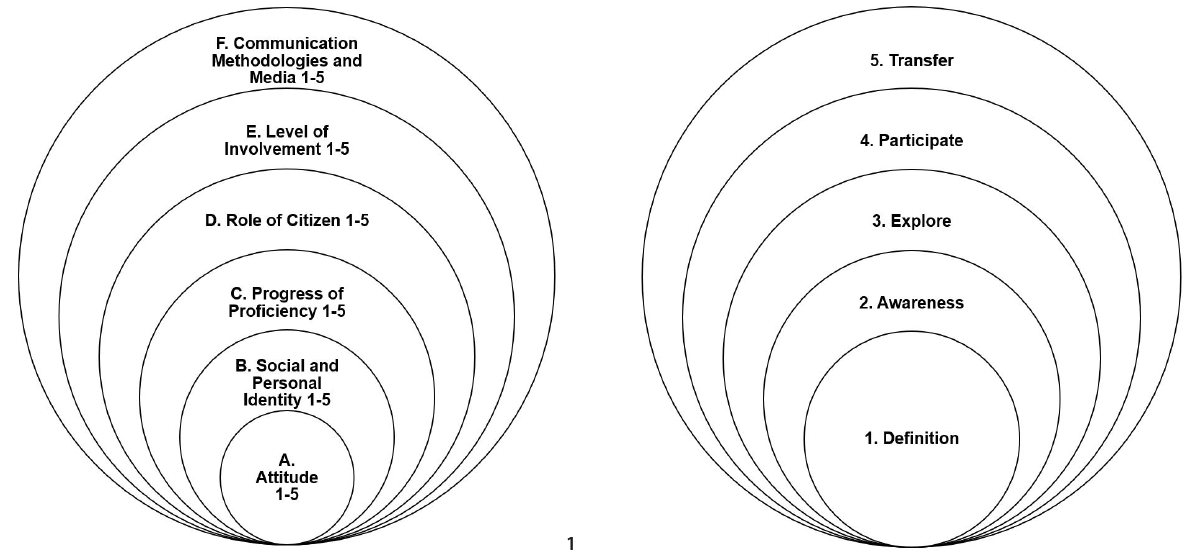
Figure 1 Elements (A to E) of a citizen’s identification process lead to targeted communication (Source: the author). Figure 2 The attitude (1 to 5) of a citizen indicated the status of the identification process (Source: the